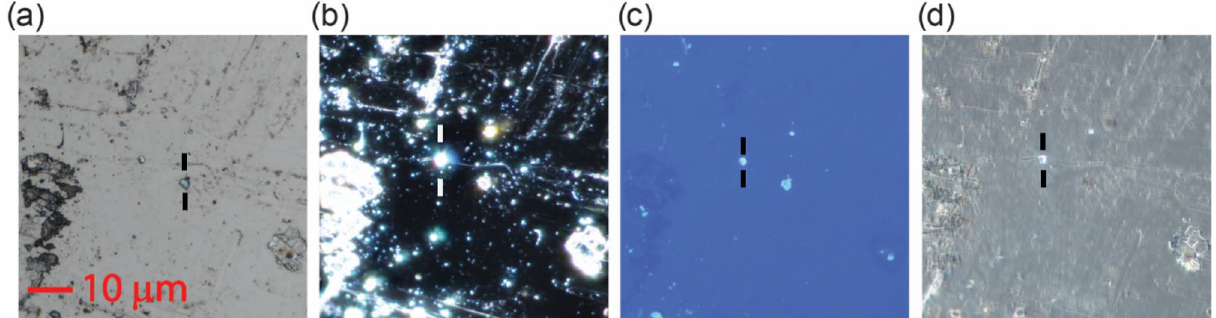
Figure 1. Optical microscope image of the HOPG sample after 13 h of UV irradiation: field ( a ), dark field ( b ), fluorescence ( c ) and polarization ( d ) set ups. Crystallites are formed at some locations on the surface (one of them is marked in the images). The rest remains apparently unaltered. Increasing the exposure time increases the number of crystallites